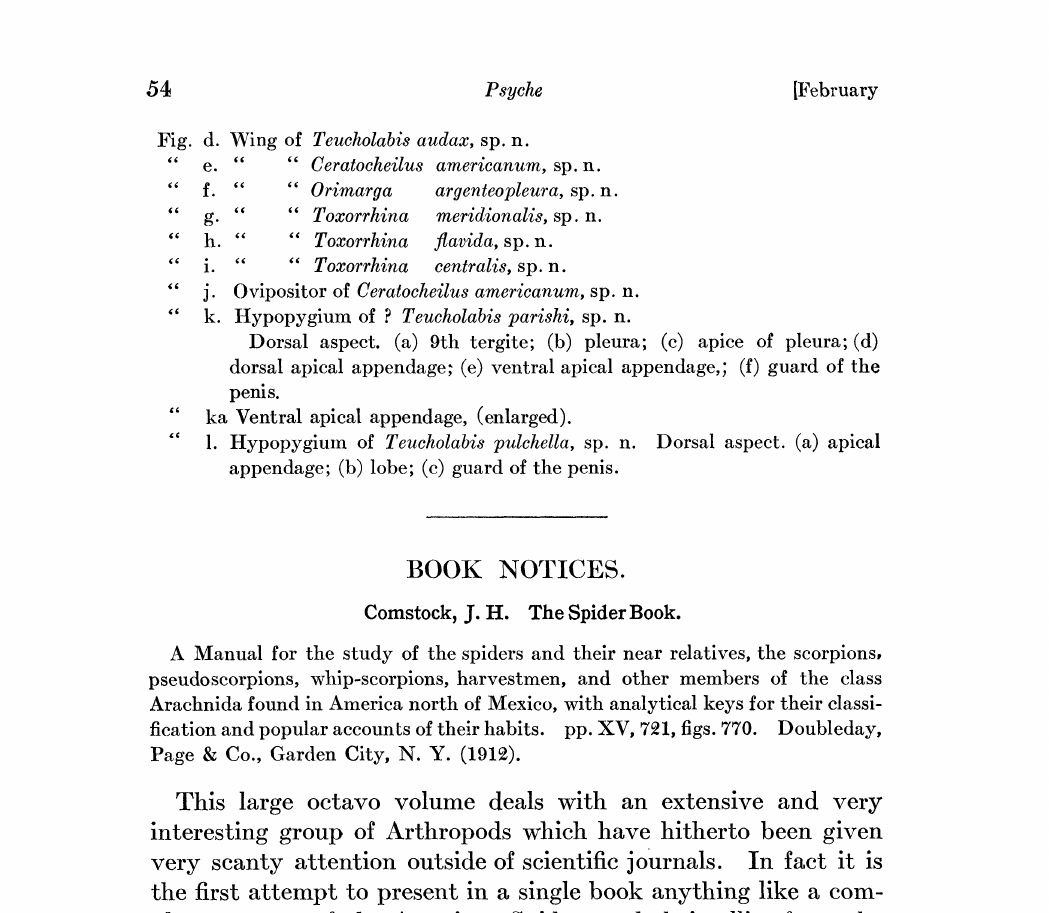
Fig. d. Wing of Teucholabis audax, sp.